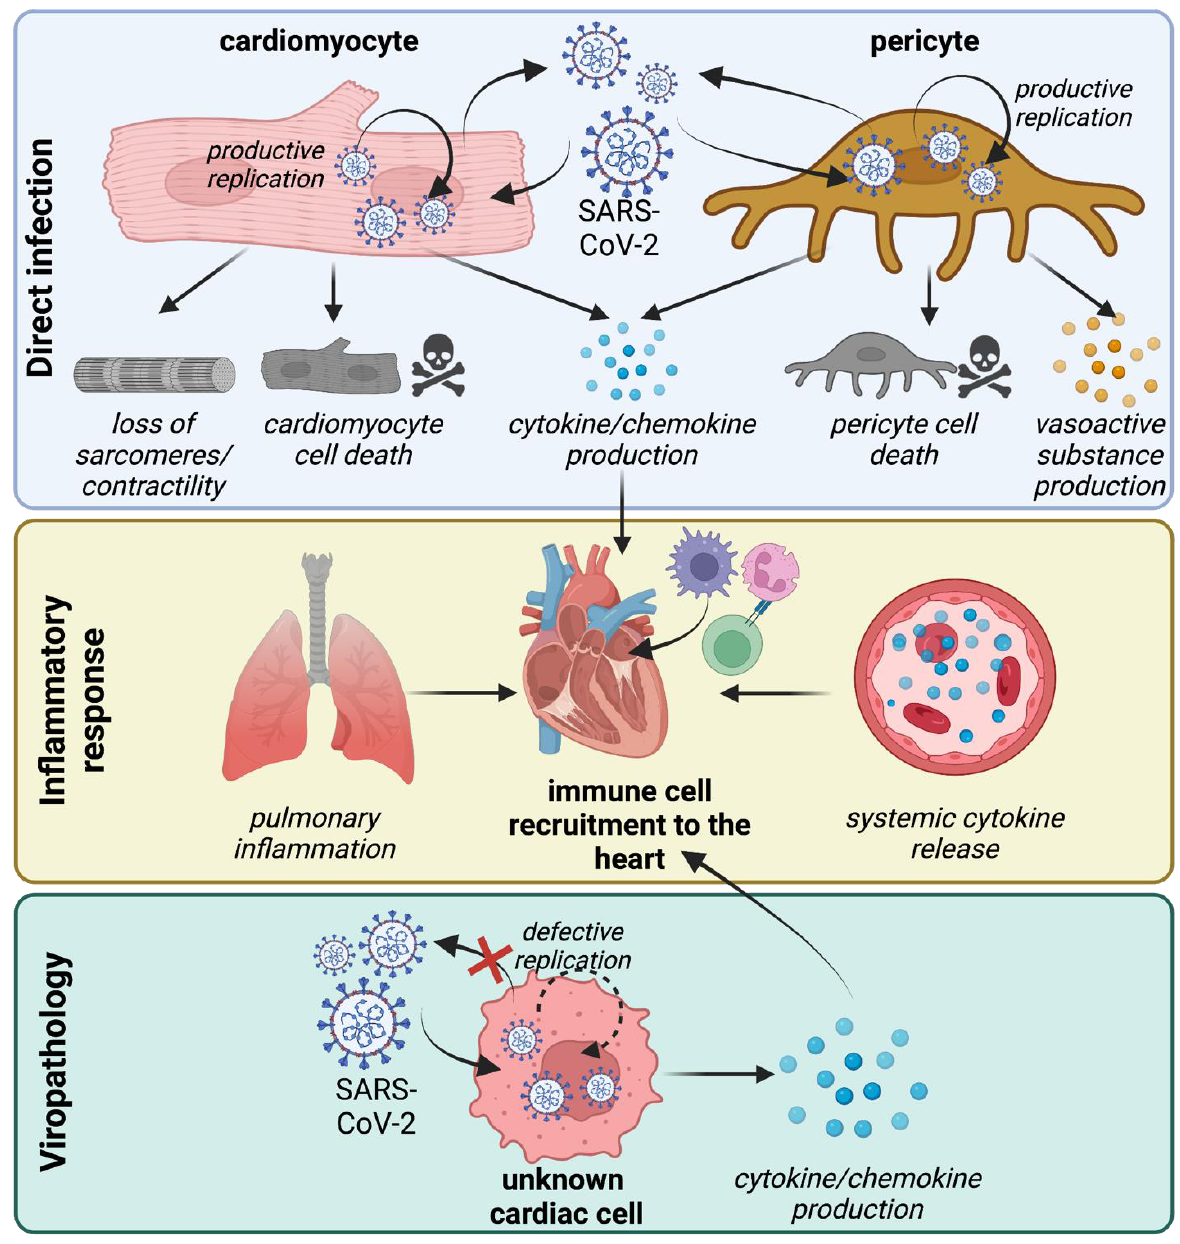
Figure 2. The pathophysiology of cardiac COVID-19. SARS-CoV-2 impacts cardiovascular physiol- ogy through the direct infection of cardiac cells, systemic inflammation, and viropathology. Direct infection ( top panel ) has been described in cardiomyocytes and pericytes. Cardiomyocyte infection results in the loss of sarcomere structure, a decrease in contractile force generation, the release of cytokines and chemokines, and the death of infected cells. In pericytes, SARS-CoV-2 infection causes the production of vasoactive substances and cytokines, and the death of infected cells. Productive replication contributes to further viral dissemination. Severe lung pathology in COVID-19 elicits systemic inflammation ( middle panel ) that contributes to immune cell recruitment and a prothrom- botic state. SARS-CoV-2 virions act as PAMPs that trigger inflammatory responses in the absence of productive infection. This is referred to as viropathology ( bottom panel ). While poorly understood in the context of the heart, viropathology may regulate the activation of macrophages and endothe- lial cells, which do not support the replication of SARS-CoV-2. This mechanism can further contrib- ute to immune cell recruitment and the generation of local inflammation within the heart.